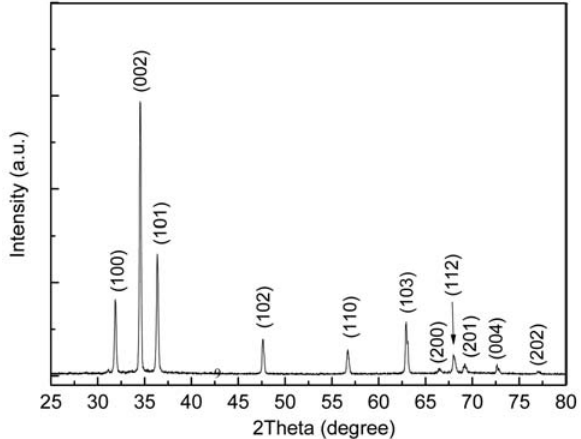
Fig. 5. XRD pattern of typical ZnO microrods.